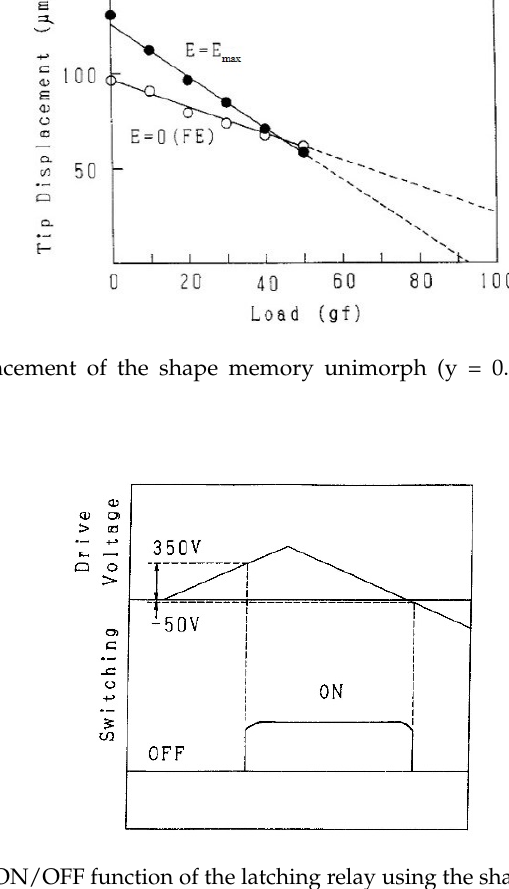
( a ) ( b ) Figure 23. Dynamical response of the latching relay: ( a ) shape memory ceramic type; and ( b ) electromagnetic coil type. 7.2. Mechanical Clamper A mechanical damper suitable for microscope sample holders has been constructed by combining a 20-layer shape memory stacked device (y = 0.0635) and a hinge-lever mechanism as shown in Figure 24 [29]. Application of a 1 ms pulse voltage of 200 V can generate the longitudinal displacement of 4 μ m in the 4 mm-thick multilayer device, leading to 30 μ m tip movement of the hinge lever after the displacement amplification. Stable grip was verified for more than several hours. This gripper is useful for optical and/or electron microscope sample stages, because no continuous electric voltage application is required during the experiment. To release the sample, small reverse pulse voltage is applied on the multilayer actuator. Figure 24. Construction of the mechanical damper using a shape memory multilayer device.